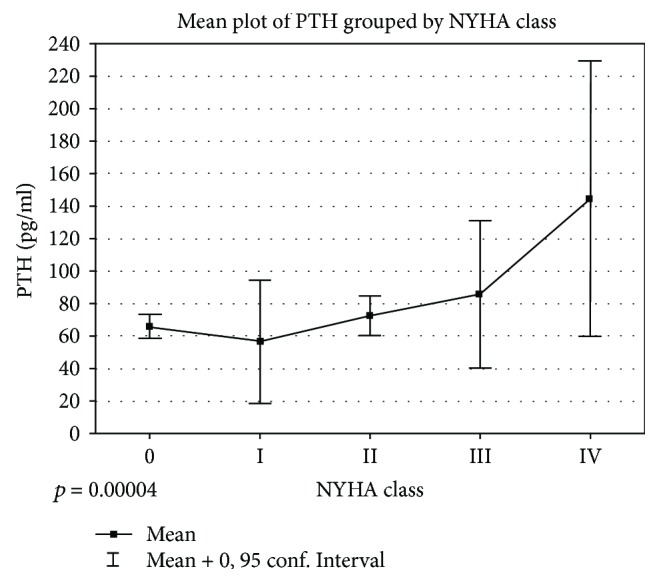
Mean plot of PTH grouped by NYHA class. NYHA: New York Heart Association; PTH: parathyroid hormone.